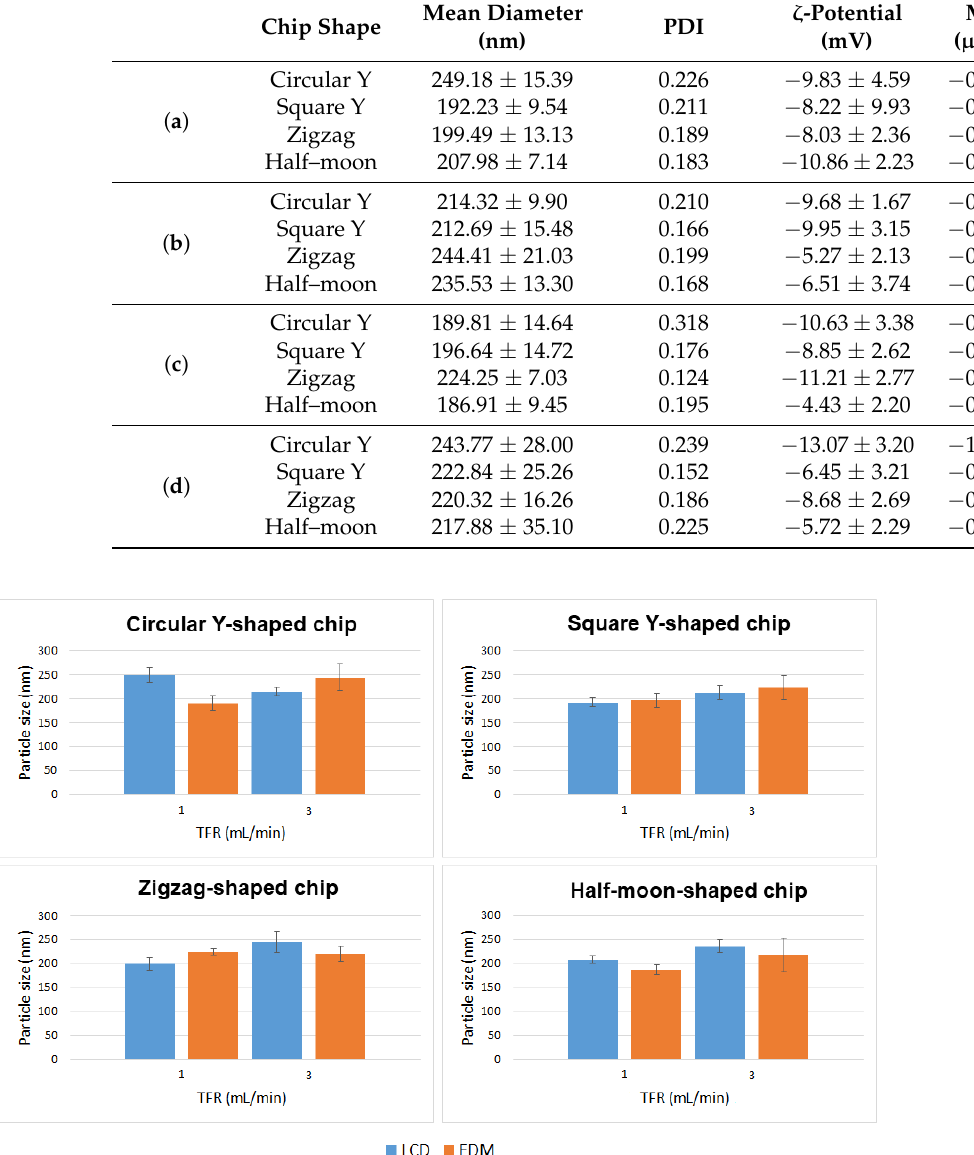
Figure 7. Mean particle size of curcumin-loaded liposomes prepared using circular Y-shaped, square Y-shaped, zigzag-shaped, and half-moon-shaped chips at TFRs of 1 and 3 mL min −1 .